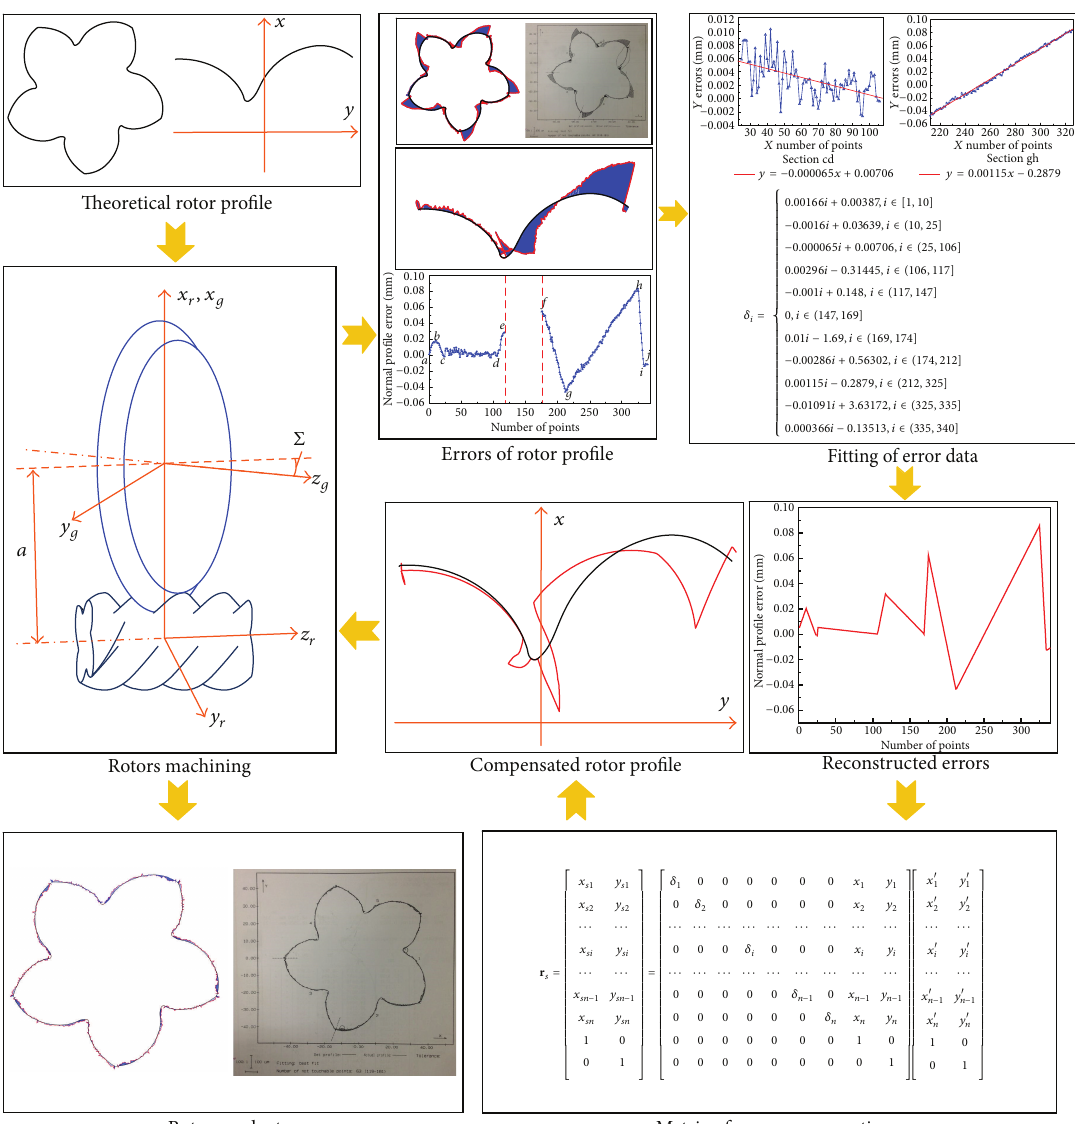
Figure 3: Procedure of error